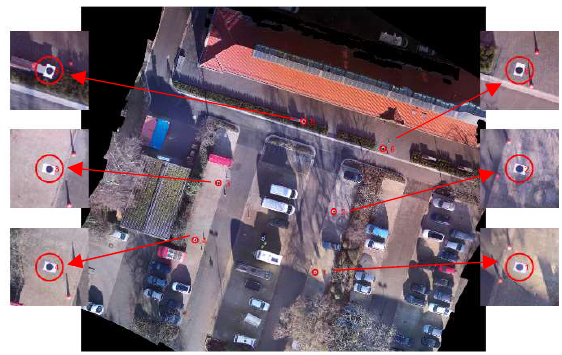
Figure 5. Visualization of the surveyed area with GCPs marked with red circles